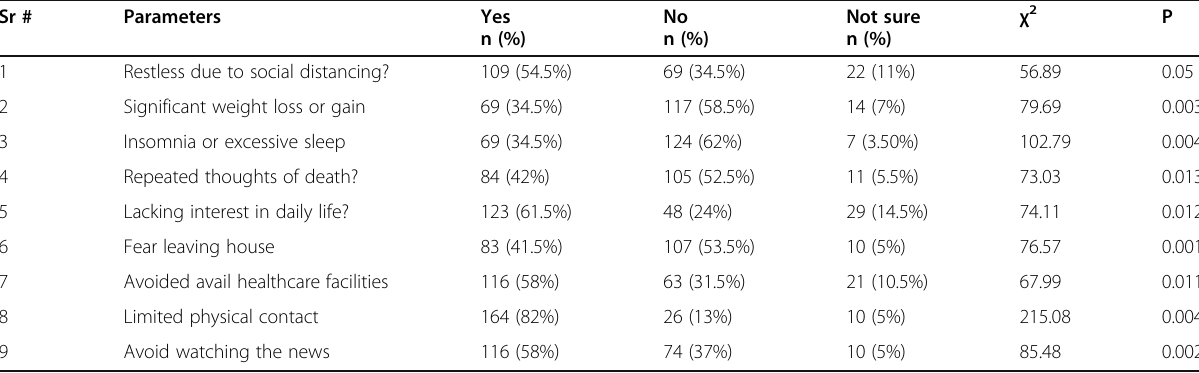
Table 3 Prevalence of anxiety-related symptoms in HCV-infected respondents regarding COVID-19 Sr